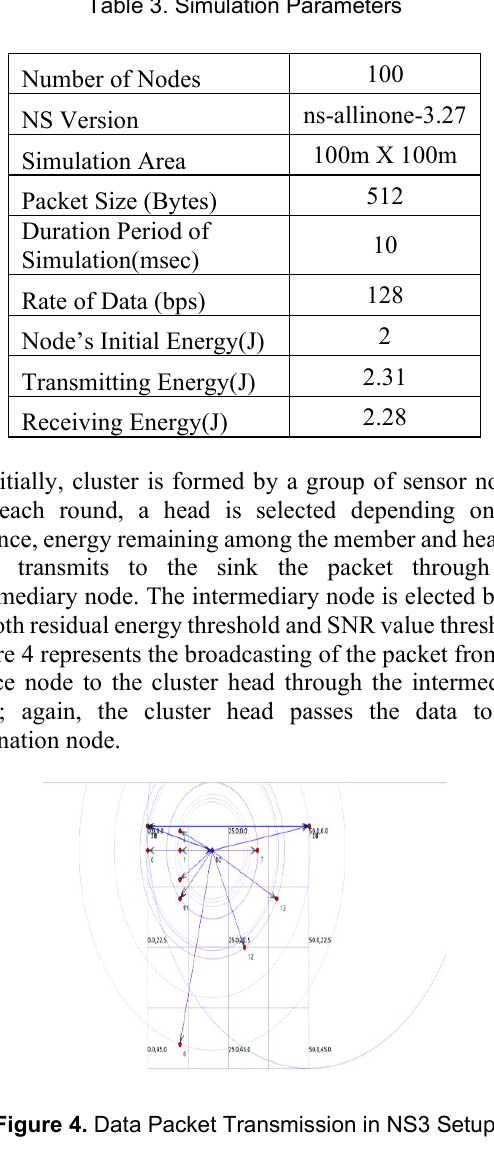
Figure 4. Data Packet Transmission in NS3